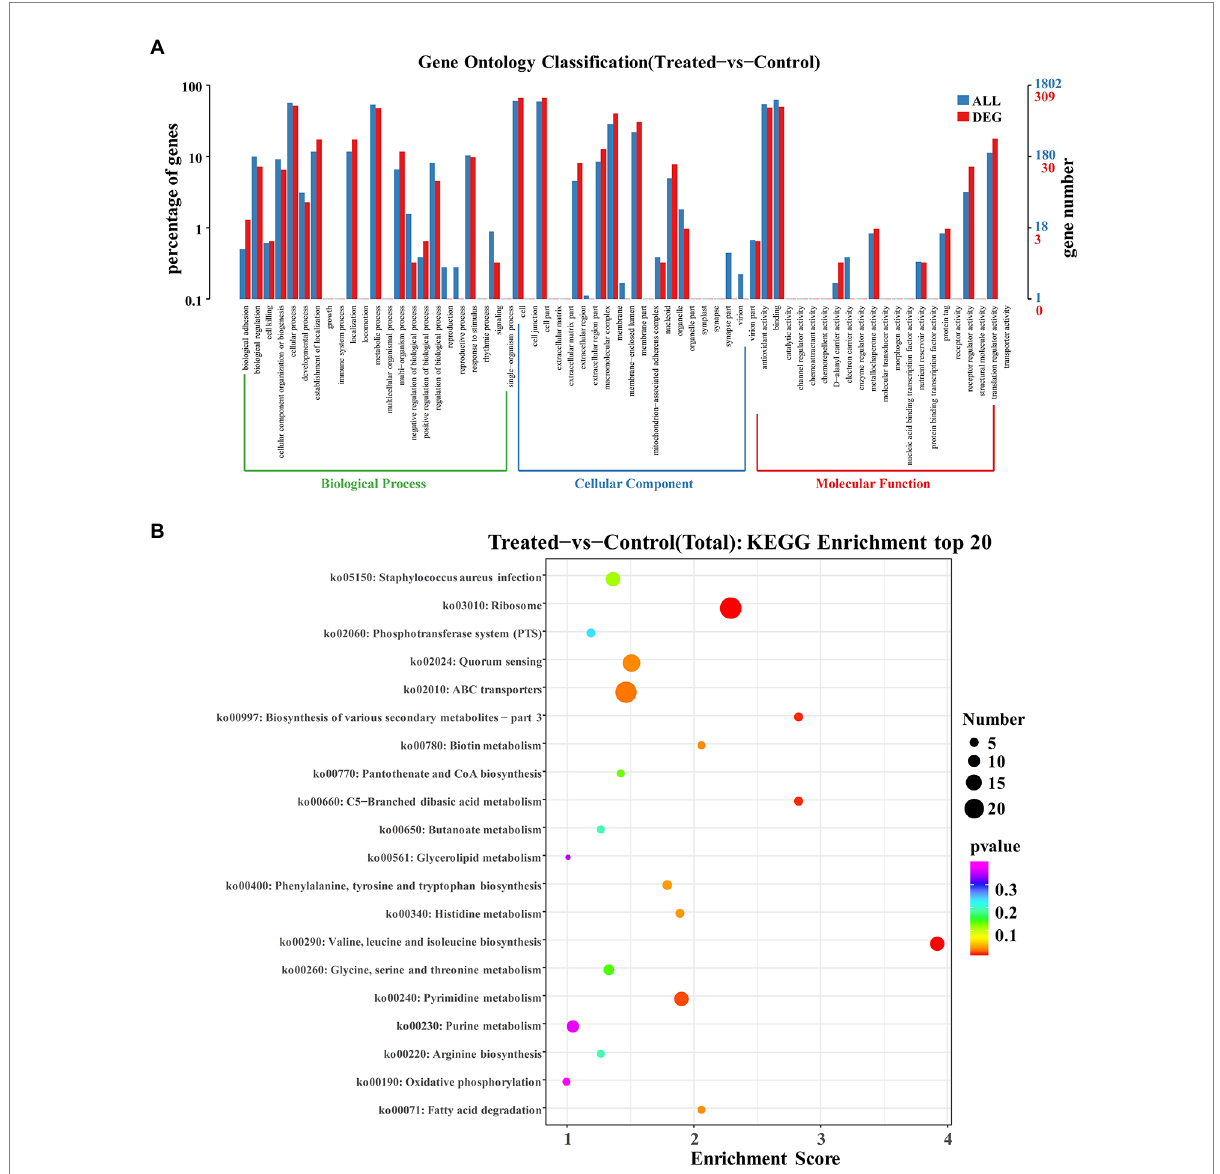
FIGURE 5 GO enrichment analysis of DEGs in Staphylococcus aureus after the action of 1/2 MIC FCS (A) . KEGG enrichment analysis of DEGs in S. aureus after the action of 1/2 MIC FCS (B)